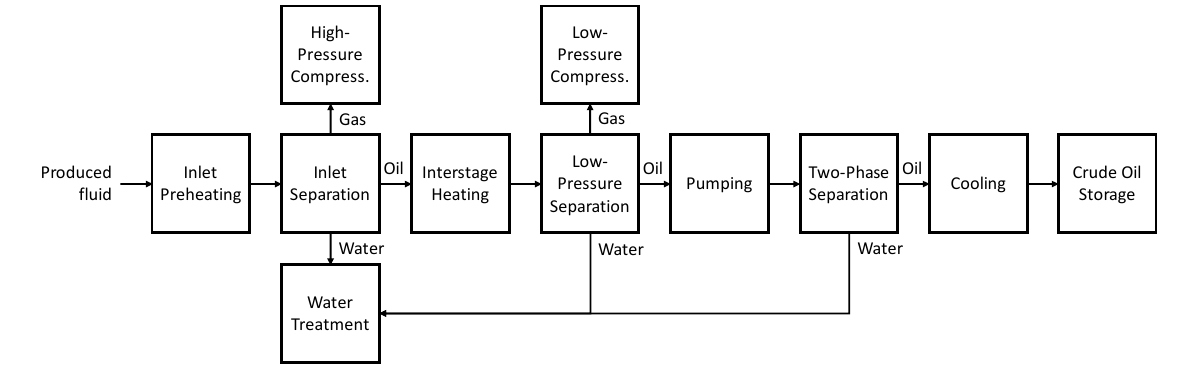
Figure 3. Block diagram of FPSO process.